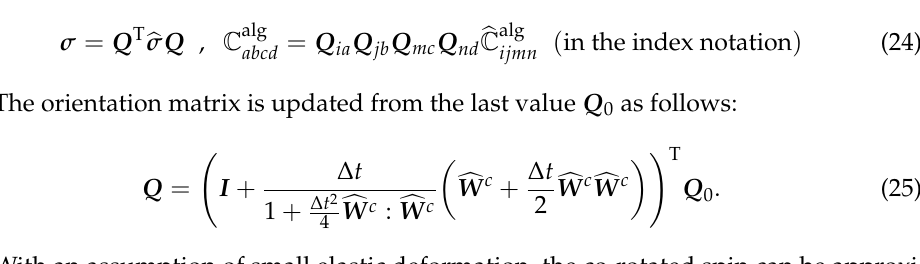
algorithmic modulus should then be rotated back into the global frame by the